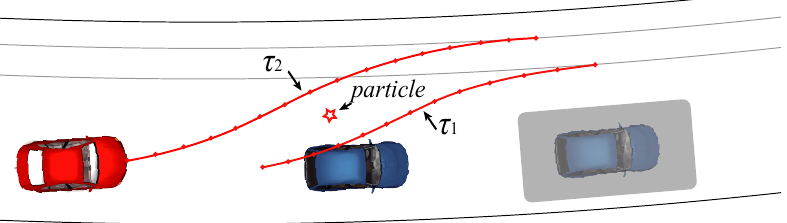
Figure 15. One generated particle and the driving envelope in the reference